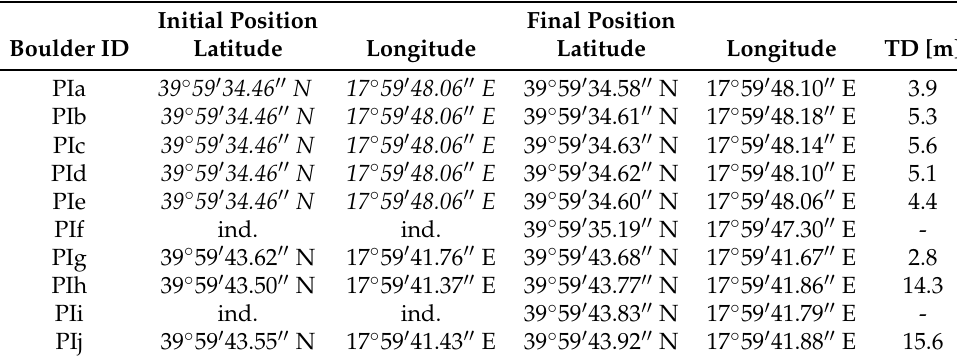
Figure A2. Punta Pizzo headland: ( a ) The boulder PIr and its socket taken from the coastline. ( b ) The same objects of a, taken from inland. ( c ) The boulder group PIa,b,c,d,e and the initial position (blue dashed line) taken from the coastline. ( d ) The same objects of c, taken from inland. Table A5. Initial and final geographical coordinates of the displaced boulders at the Punta Pizzo headland; ind.,